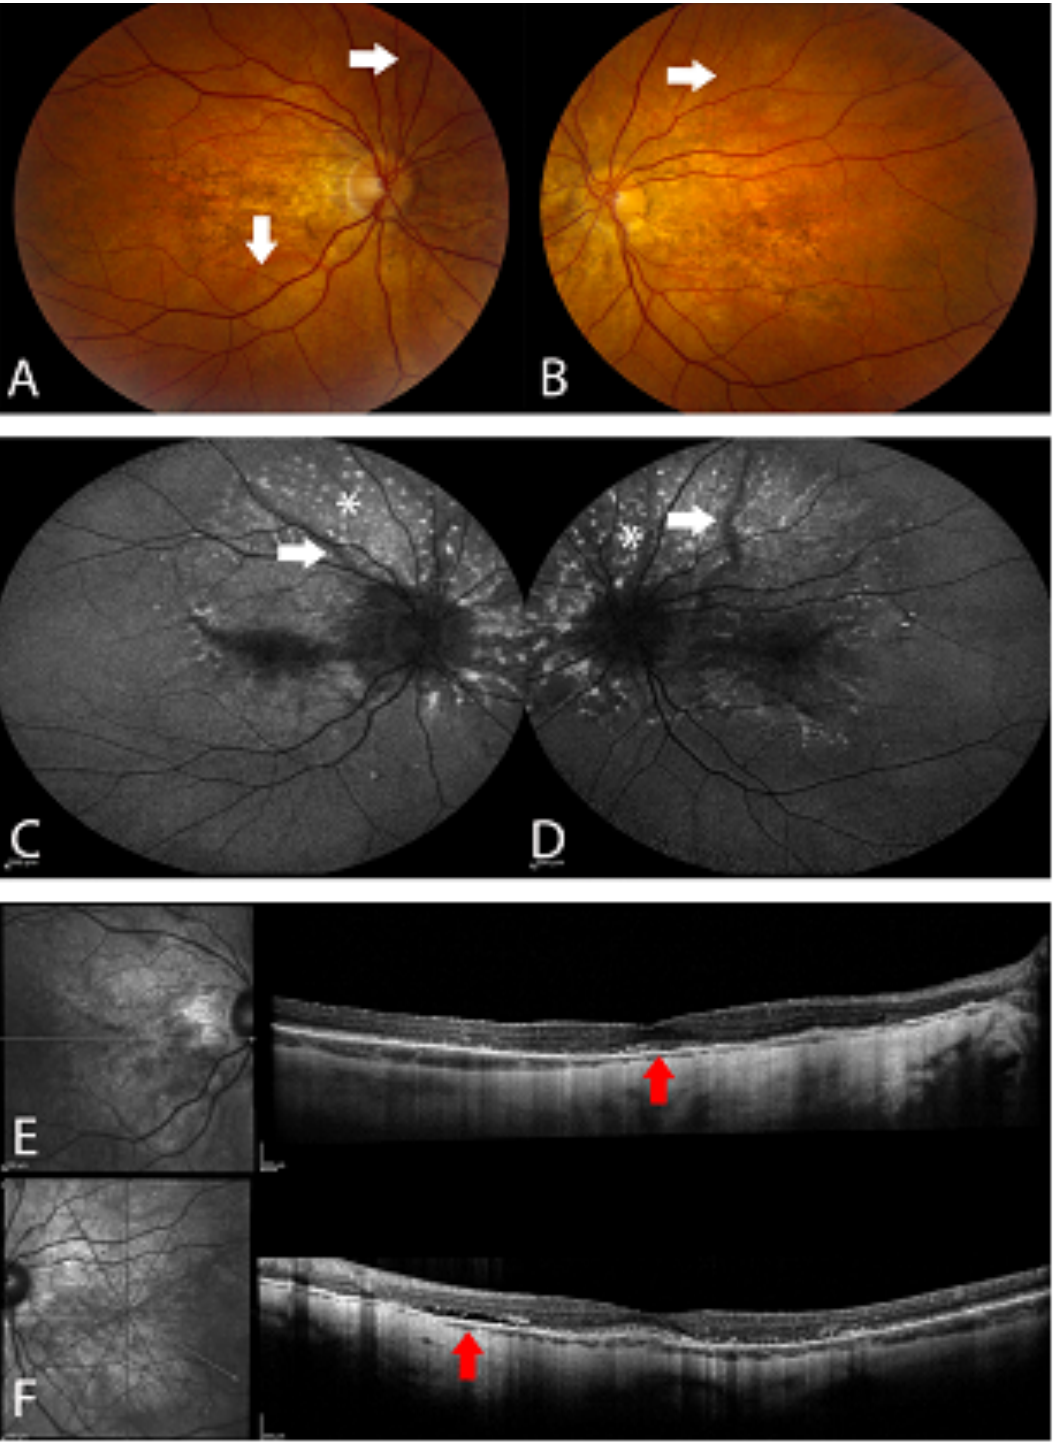
Figure 1. Fundus images (A) with bilateral hyperpigmented lines emanating from the discs, consistent with angioid streaks (white arrows). On FAF (B), the angioid streaks are easily appreciated (white arrows). Also seen are punctate areas of hyper- and hypo- FAF surrounding the disc and within the fovea (asterisks). The hyper-FAF lesions are felt to be accumulations of photoreceptor lipofuscin while the hypo-FAF lesions are thought to be related to subretinal drusenoid deposits. On OCT (C-F), there is evidence of bilateral subretinal fluid (red arrows) consistent with chronic RPE damage that are stable over five years (C & D images taken five years before E & F